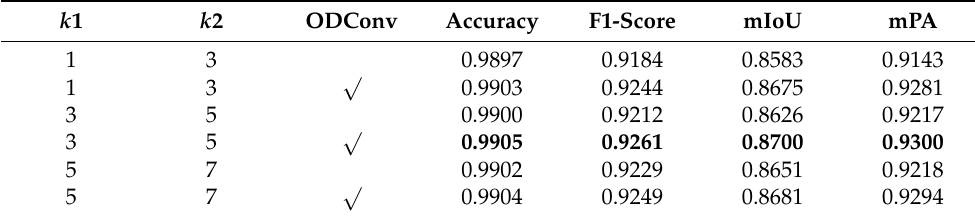
Table 3. Results of different kernel size in block.